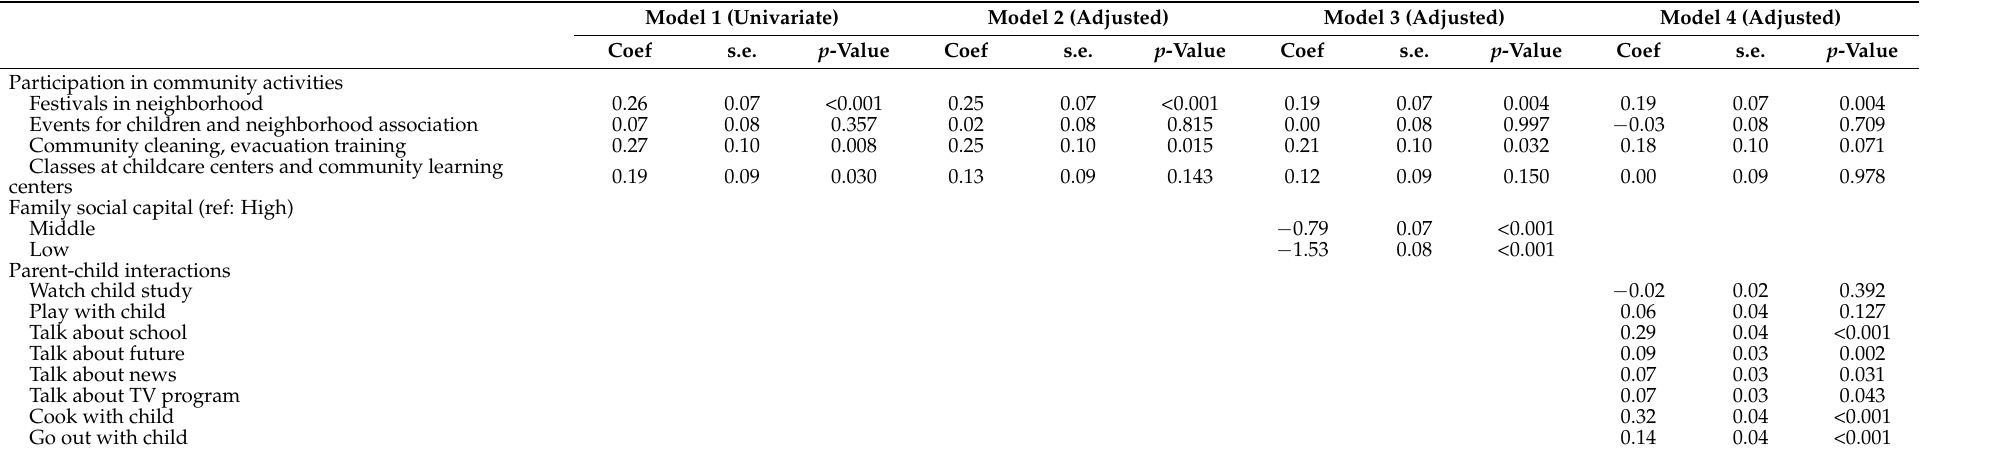
Table 4. Associations between participation in community activities and SDQ prosocial